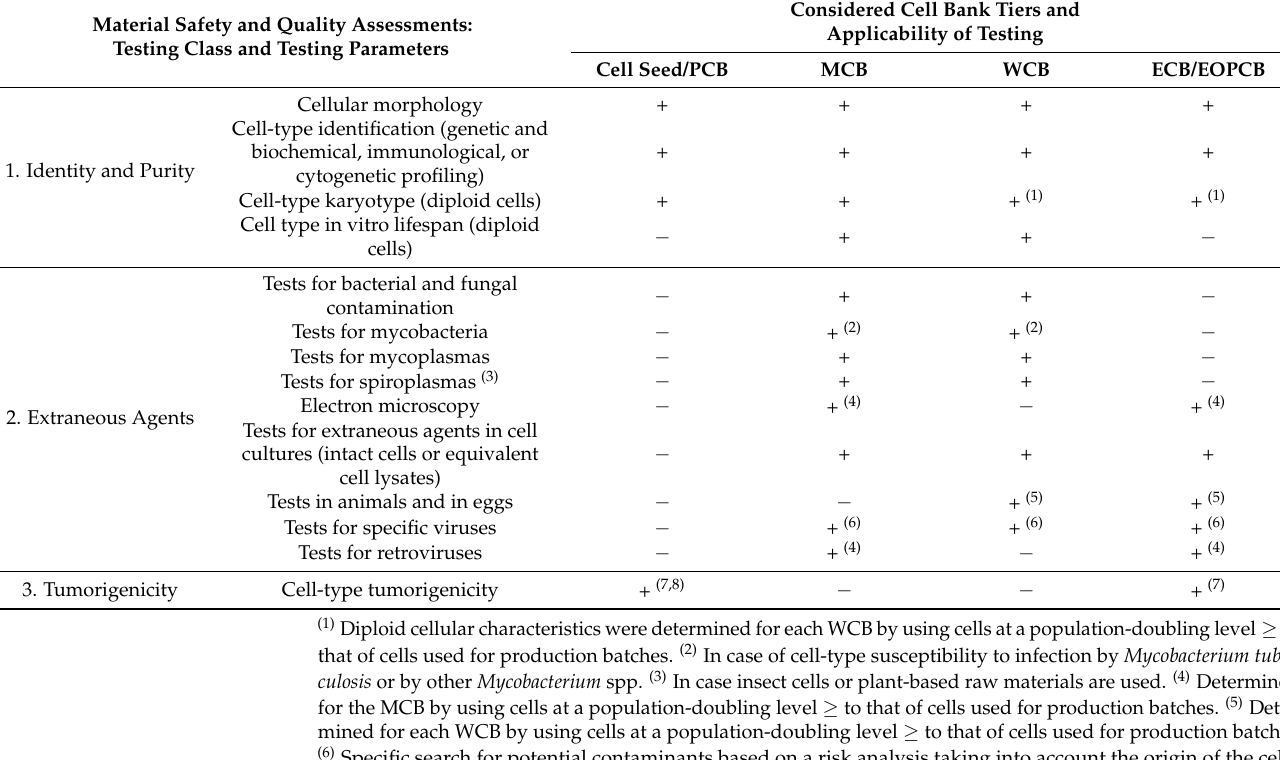
Table 2. Example of a biosafety-testing scheme and of cellular substrate qualification requirements applicable for cell substrates used in the GMP production of vaccines for human use, based on the Ph. Eur. 9.0 general chapter 5.2.3., 01/2017:50203 [65]. Required testing is indicated by a “+” symbol.